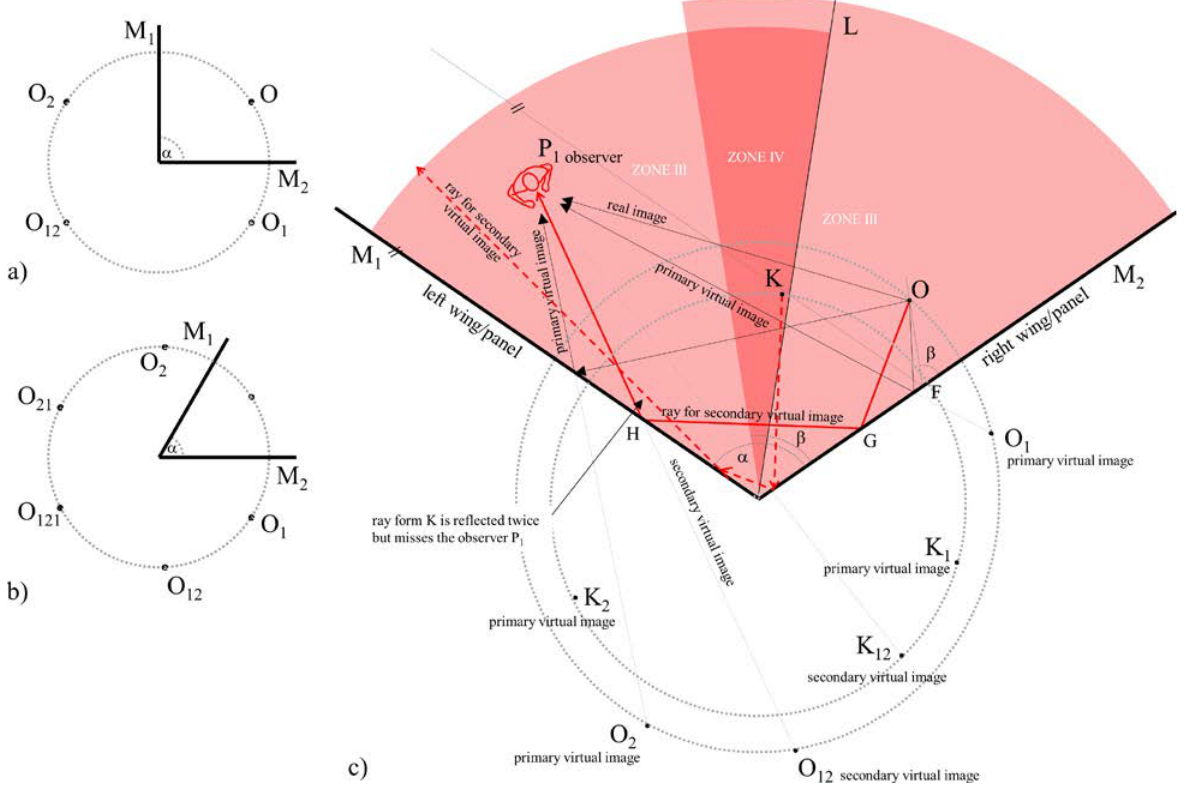
Fig. 6. Geometrical analysis of the visibility of secondary virtual image of the objects O and K for the observer P 1